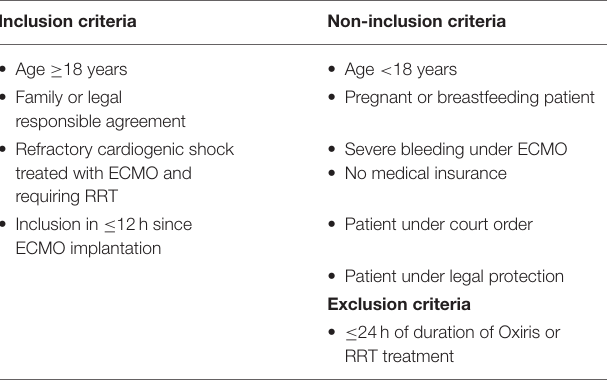
TABLE 2 | Inclusion, non-inclusion and exclusion criteria of the study. Inclusion criteria Non-inclusion